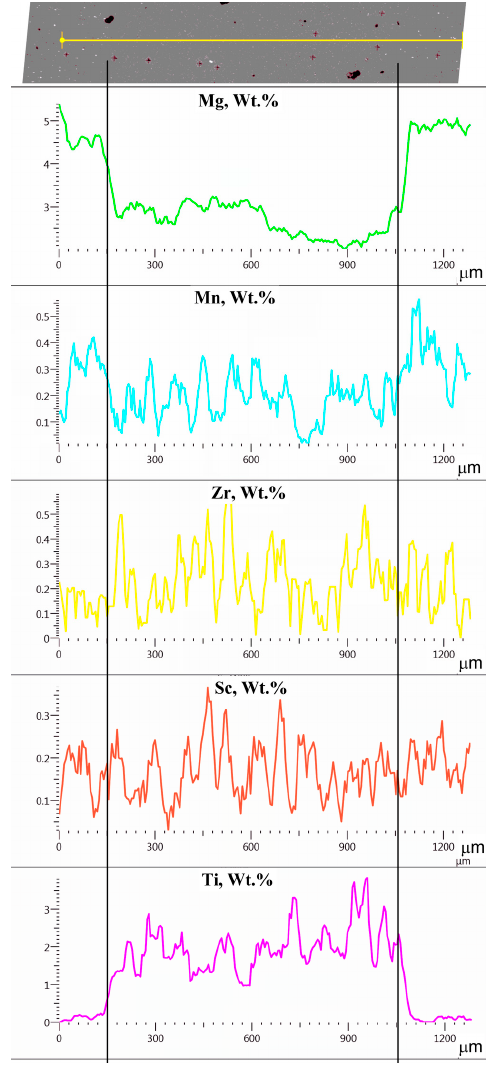
Figure 5. Distribution of the elements in the base metal (outside the lines) and the welding zone (inside the lines) in the Al-4.7Mg-0.32Mn-0.21Sc-0.1Zr alloy after welding with AlTiB.